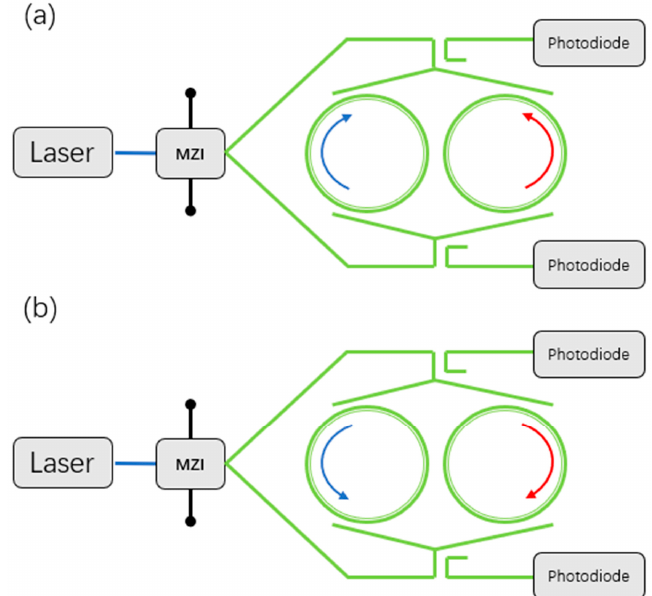
Figure 5. Reciprocal sensitivity enhancement architecture. By using a Mach–Zehnder interferometer (MZI), the ring resonators can be fed from two different directions, and the output toggles between two photodiodes.